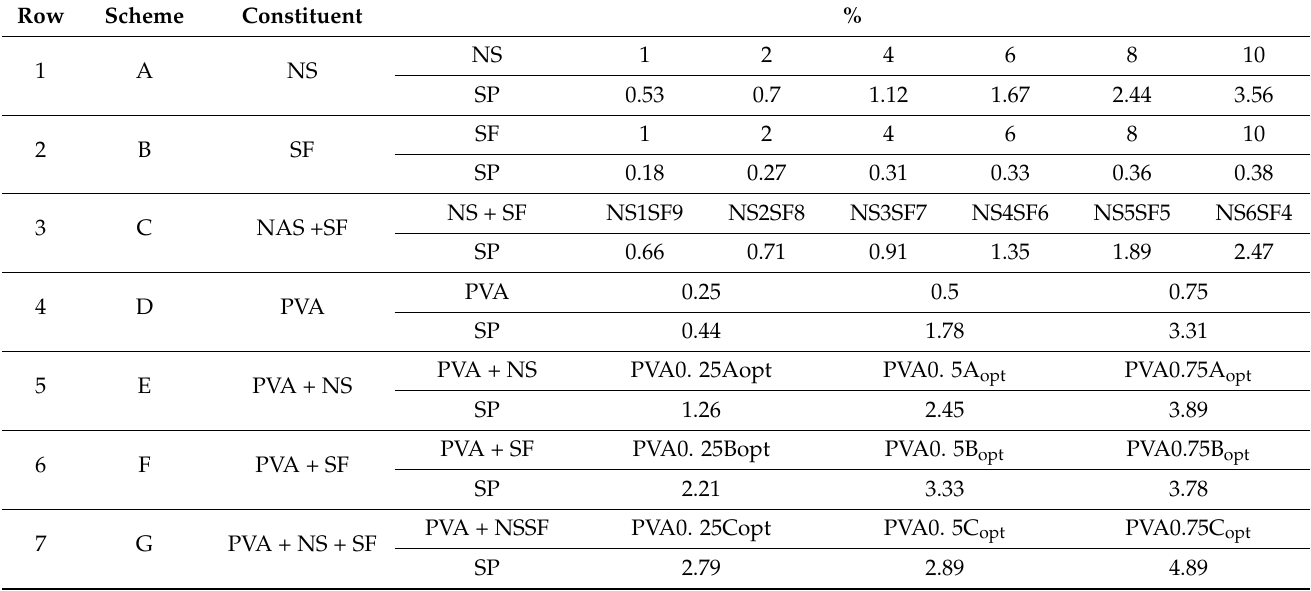
Table 4. Percentages of nano-silica, micro-silica, PVA, and superplasticizer